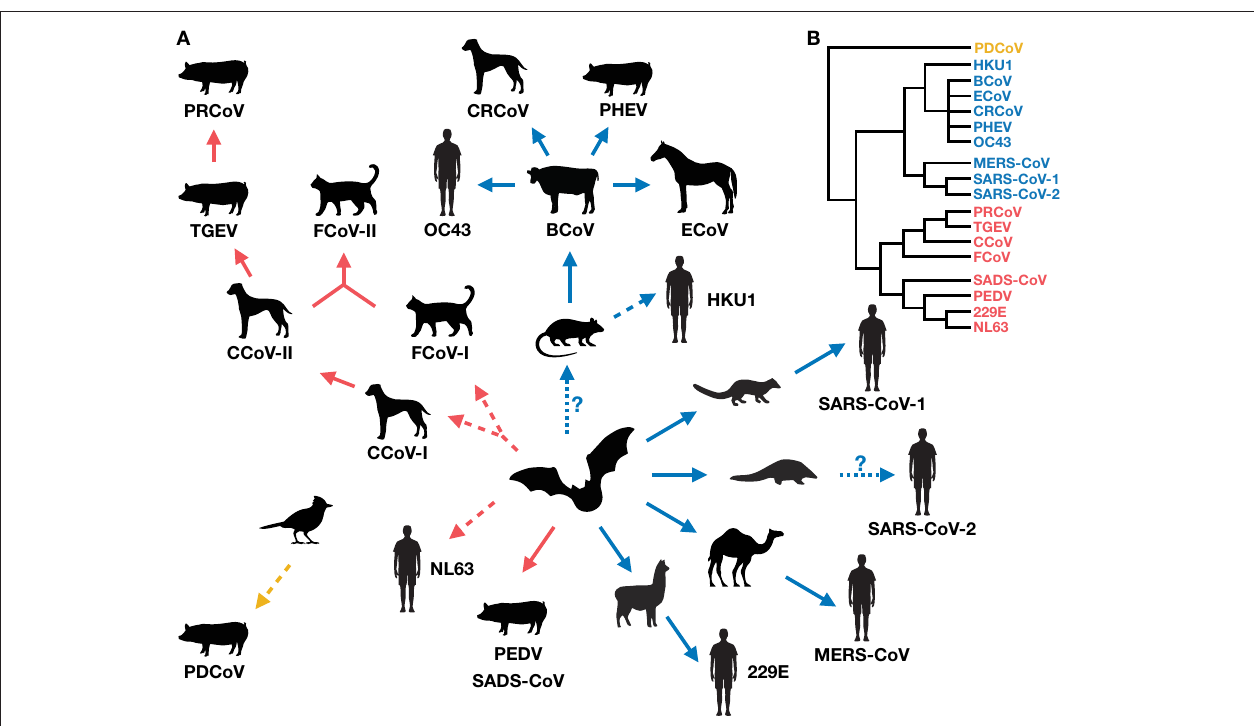
FIGURE 1 | (A) The evolution and radiation of coronaviruses in humans and domestic mammals (via potential wild intermediate spillover host species). The radiation suggests there could be a vicious cycle of coronavirus emergence, whereby newly emerged viruses in new hosts increase the likelihood of producing more new recombinants. Red, blue and yellow arrows indicate the direction of spillover of coronavirus emergence for Alphacoronaviruses , Betacoronaviruses, and Deltacoronaviruses , respectively. Solid arrows represent direct (confirmed or suspected) coronavirus transmission between host species (although indirect transmission via an unidentified intermediate host is not excluded), and dashed arrows represent suspected indirect transmission via an unidentified intermediate host (although direct transmission is not excluded) ( 10, 17, 104, 127, 139, 141, 156). Dotted arrows with a question mark indicate uncertain spillover events. (B) A simplified phylogeny of the coronaviruses covered in this review, drawn from published findings ( 5, 129,